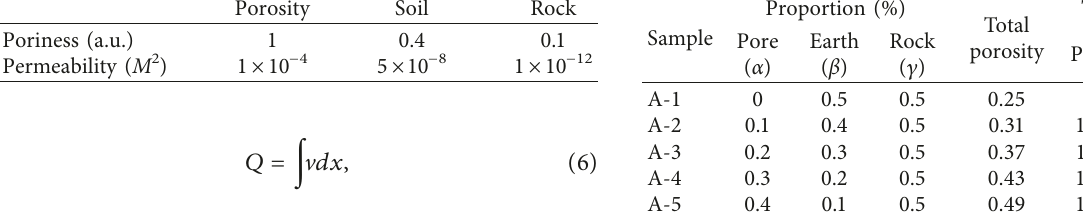
Table 2: Different medium permeability parameters. Porosity Soil Rock Poriness